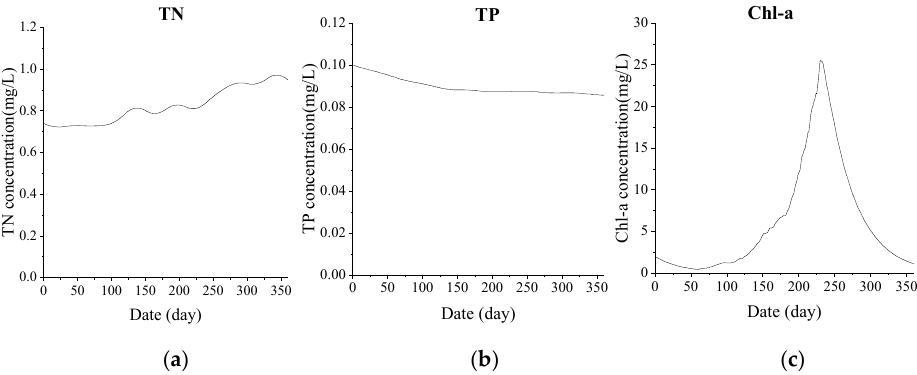
Figure 20. Predicted value of TN, TP, Chl-a concentration throughout whole year. ( a ) TN concentration; ( b ) TP concentration; ( c ) Chl-a concentration.